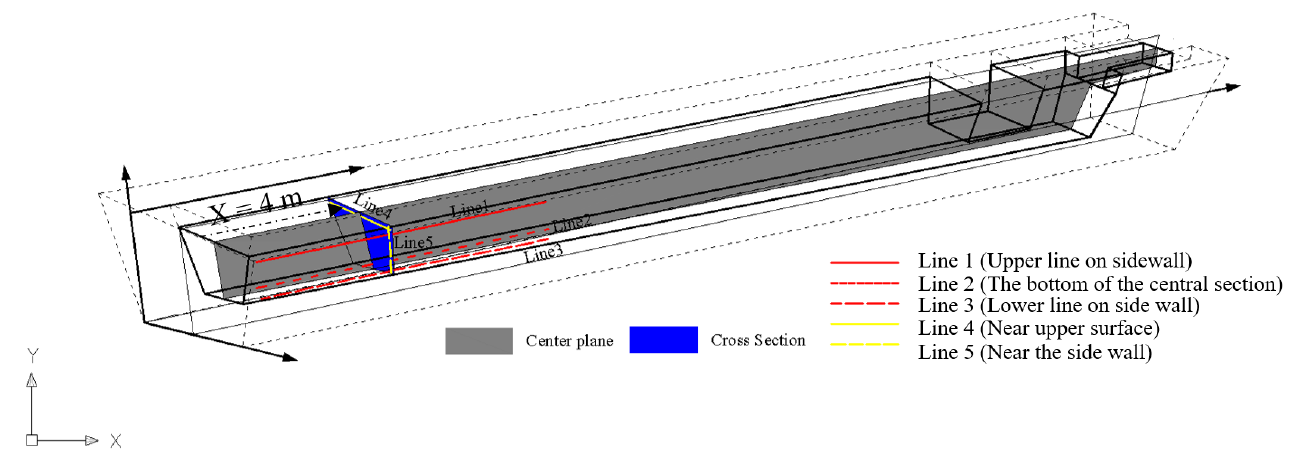
Figure 4. Post-processing inspection positions for transient calculation of the main trough.